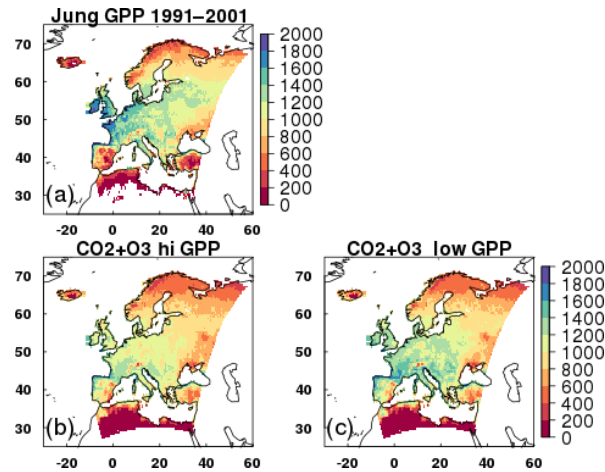
Figure 3. Mean GPP (gCm 2 yr − 1 ) from 1991 to 2001 for (a) the observationally based globally extrapolated Flux Network model tree ensemble (MTE) (Jung et al., 2011); (b, c) model simulations with transient CO 2 and transient O 3 (run_both_CO 2 + O 3 ), with high and low plant O 3 sensitivities,